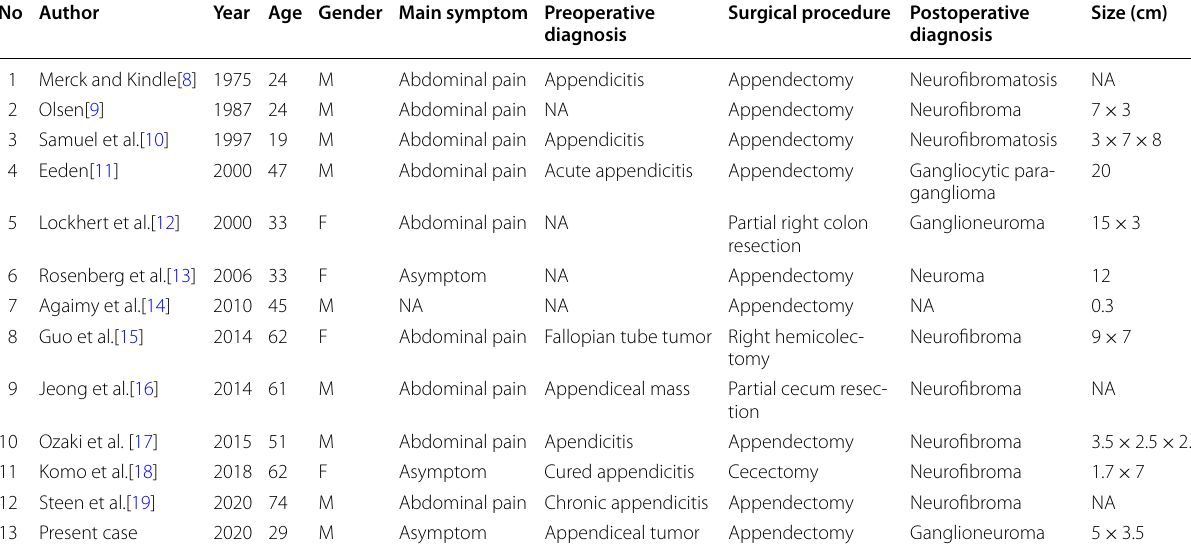
Table 1 List of reported cases of appendiceal tumor in